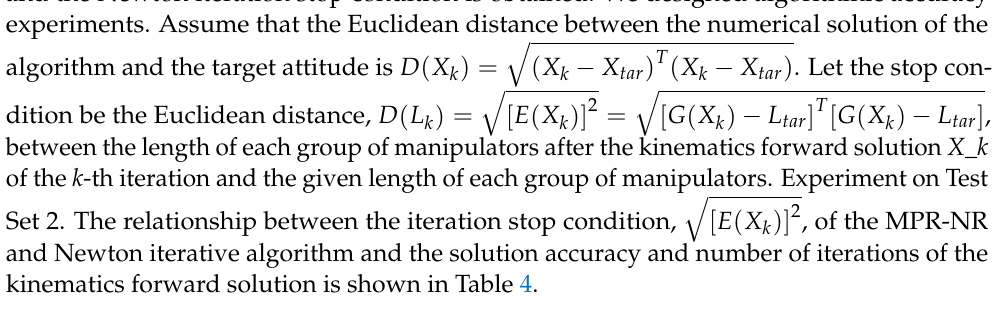
Table 4. Relationship between iteration stop conditions and solution accuracy and number of